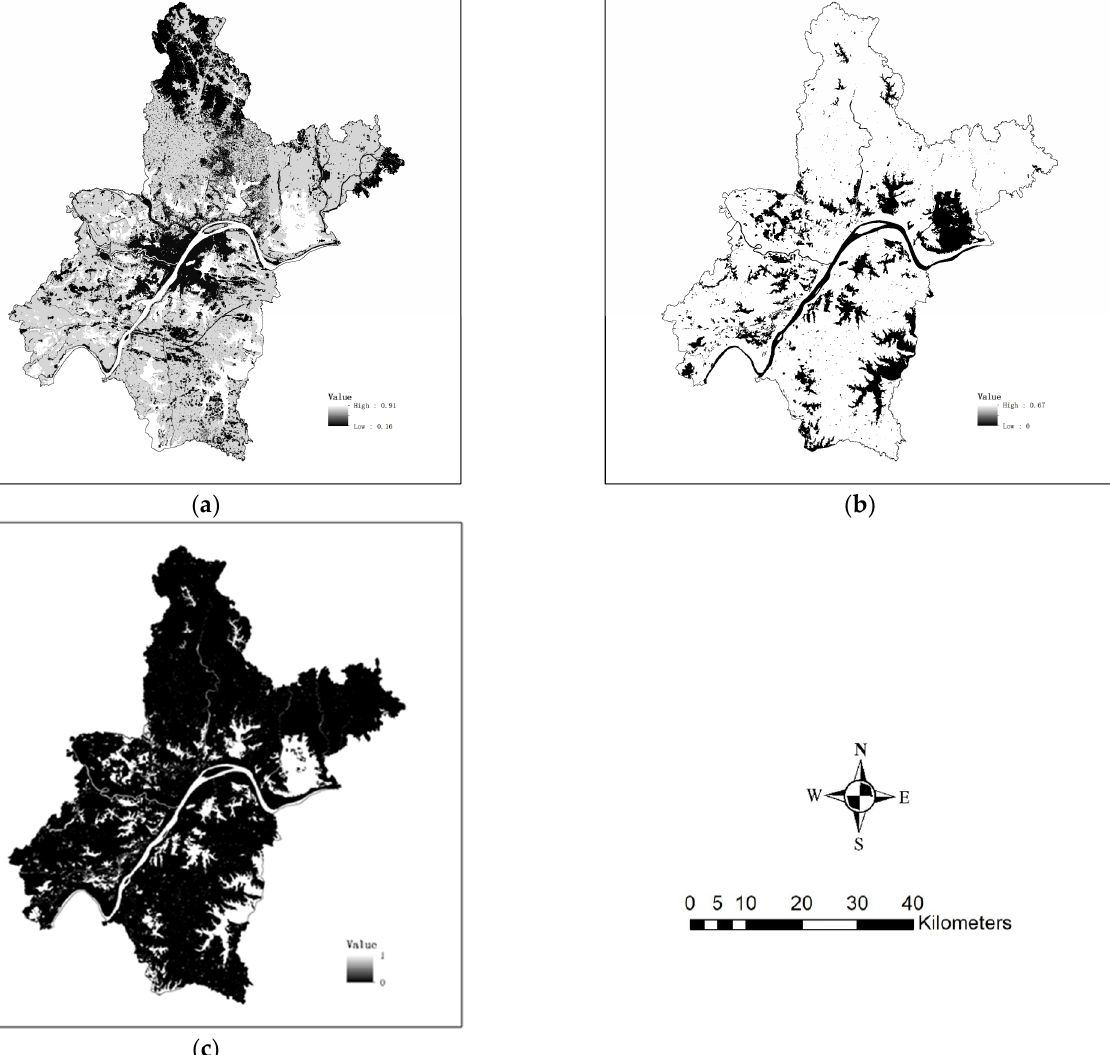
Figure 3. The surface of local OAs ( a ), the surface of local UAs for cultivated land ( b ), and the surface of local PAs for water bodies ( c ), predicted using CCAErrMat.